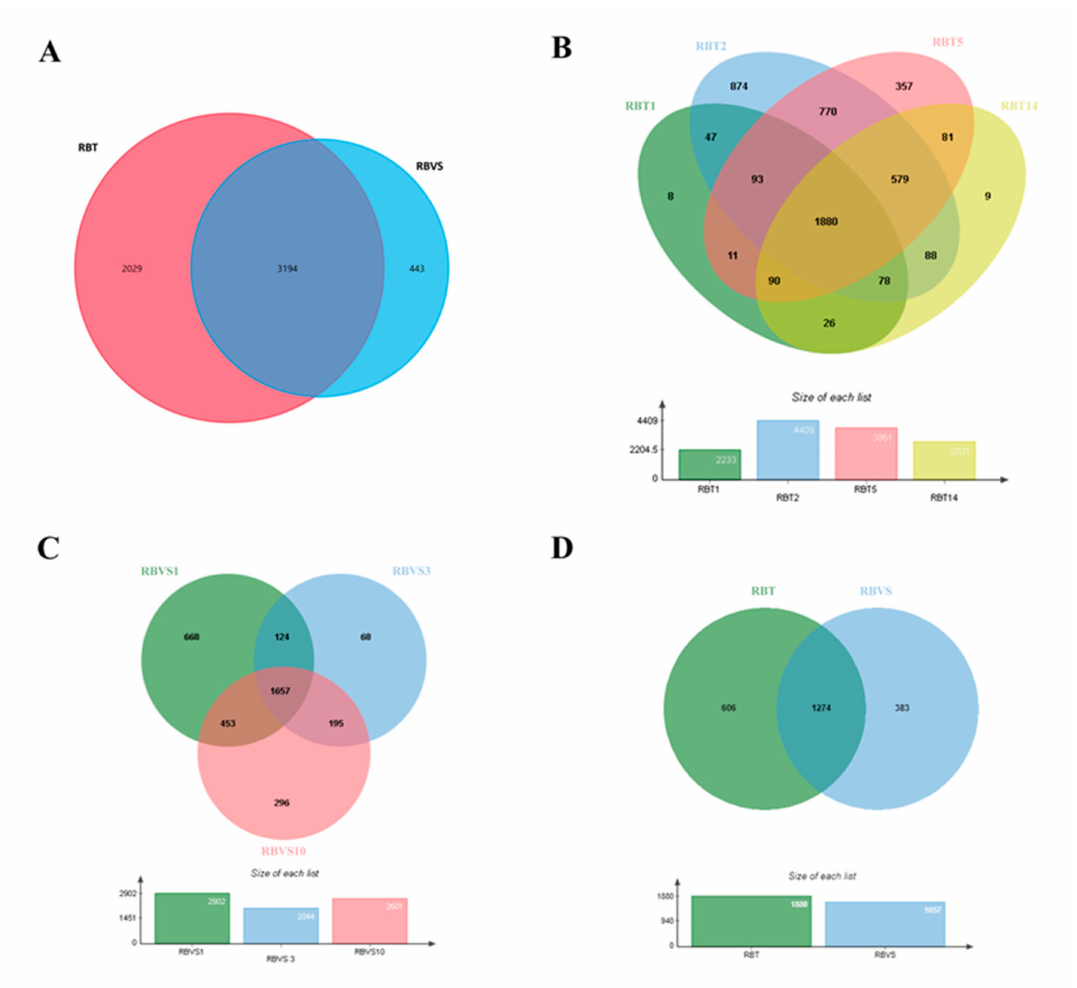
Figure 2. Proteomic analysis of RBT- and RBVS-derived exosomes. ( A ) Venn diagram of the total number of detected proteins in RBT and RBVS-derived exosomes. ( B ) Venn diagram of proteins identified in single RBT1, RBT2, RBT5 and RBT14 cell lines. Notably, 1880 proteins resulted present in exosomes obtained from all RBT cell lines. ( C ) Venn diagram of proteins detected in single RBVS1, RBVS3 and RBVS10 cell lines. Moreover, 1657 proteins were shared by all the samples. ( D ) Additionally, 606 proteins were exclusively present in RBT-derived exosomes, while 383 proteins were exclusively present in RBVS-derived exosomes. Furthermore, 1274 proteins were shared by the two